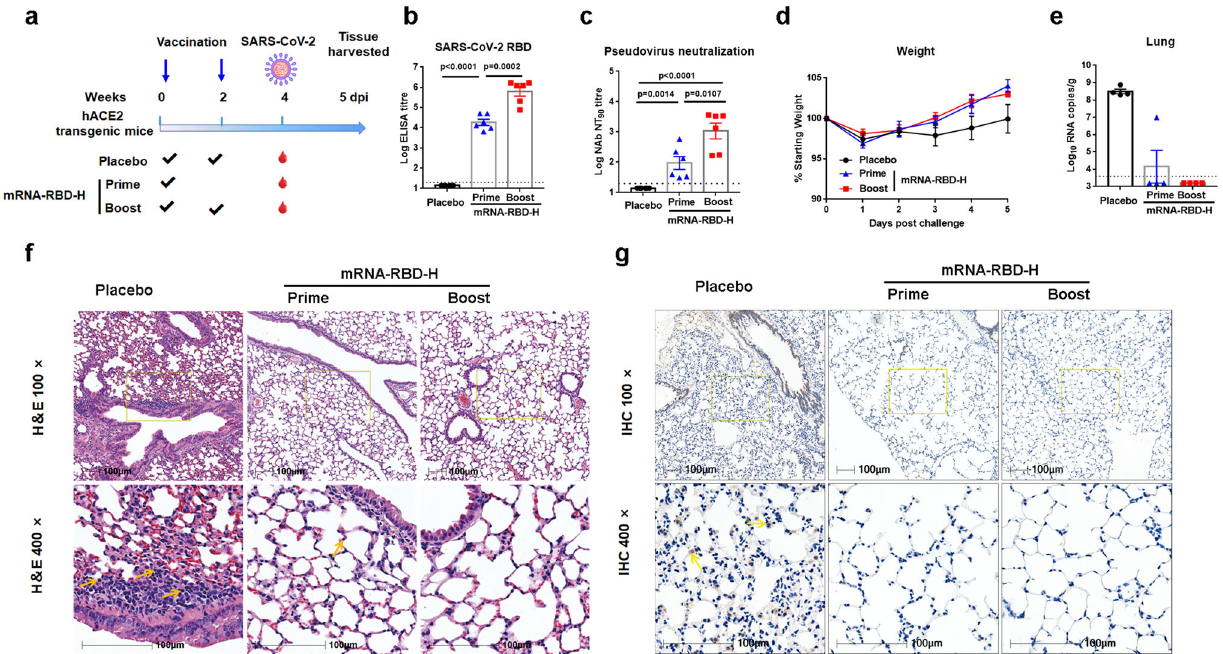
Fig. 3 Protection ef fi cacy of mRNA-RBD in hACE2 transgenic mice against SARS-CoV-2. a-d Groups of hACE2 transgenic mice ( n = 6) received one (prime group) or two (boost group) doses of mRNA-RBD-H or placebo via the i.m. route. Four weeks post initial vaccination, mice were challenged with 1 × 10 5 FFU of SARS-CoV-2 virus. a Mice immunization and challenge schedule. The blue arrows indicate the time of vaccination. b , c Sera collected at 4 weeks post initial vaccination were examined for IgG ( b ) and neutralizing antibody ( c ) titers. d Mice weight change after challenge. e Virus titers in lungs of challenged mice ( n = 4). f Representative histopathology (H&E) of lungs in SARS-CoV-2-infected hACE2 mice (5 dpi). In fi ltration of lymphocytes within alveolar spaces is indicated by yellow arrows. Scale bar, 100 μ m. g Representative immunohistochemistry (IHC) of lung tissues with SARS-CoV-2 N- speci fi c monoclonal antibodies. Virus is indicated by yellow arrows. Scale bar, 100 μ m. mRNA-RBD-H indicates the high-dose vaccine (15 μ g). Data are means ± SEM (standard error of the mean). Comparisons were performed by Student ’ s t -test (unpaired, two tailed). Placebo animals = black circles; one injection-animals = blue triangles; two injections-vaccinated animals = red squares; dotted line = the limit of detection. Data are one representative result of two independent experiments. Source data are provided as a Source Data fi